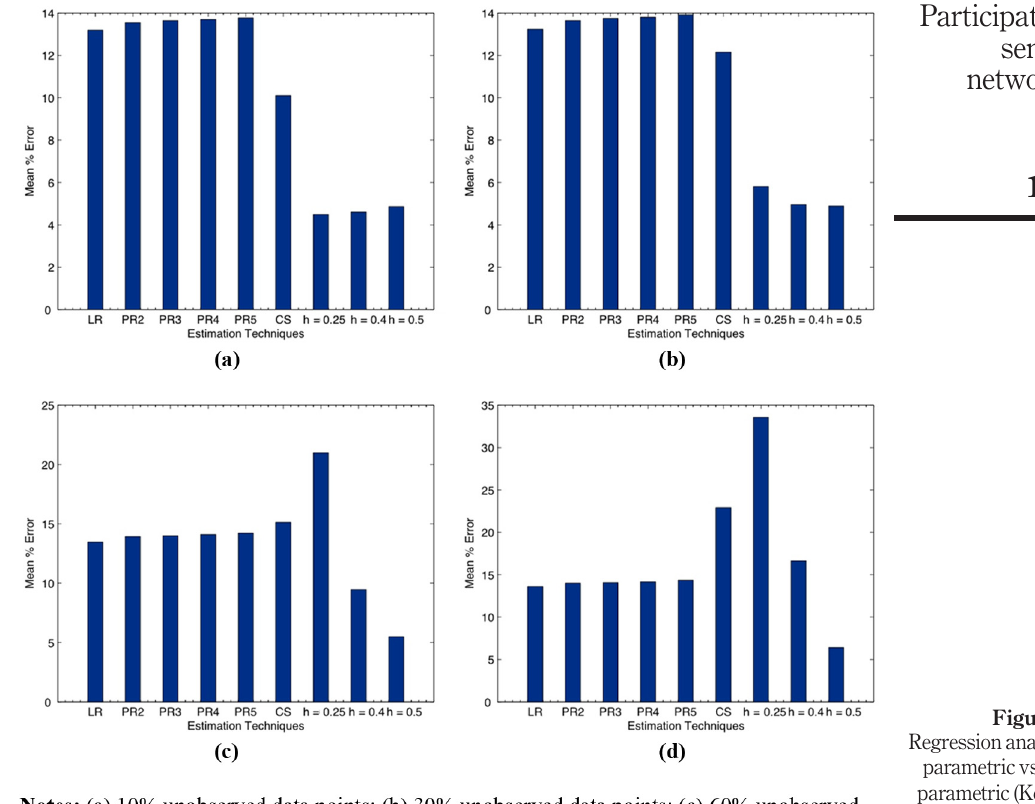
Figure 3. Regression analysis: parametric vs non- parametric (Kernel)